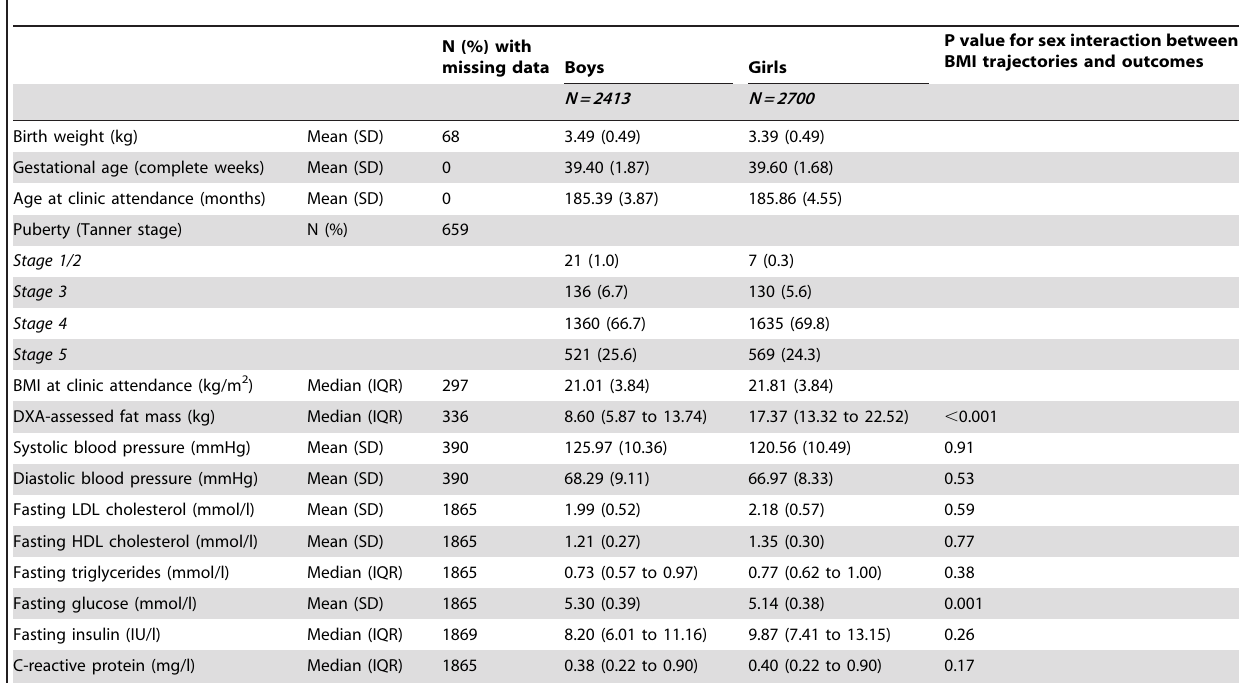
Table 1. Summary of 5113 participants attending the 15-year research clinic, and their body composition and cardiovascular risk factor